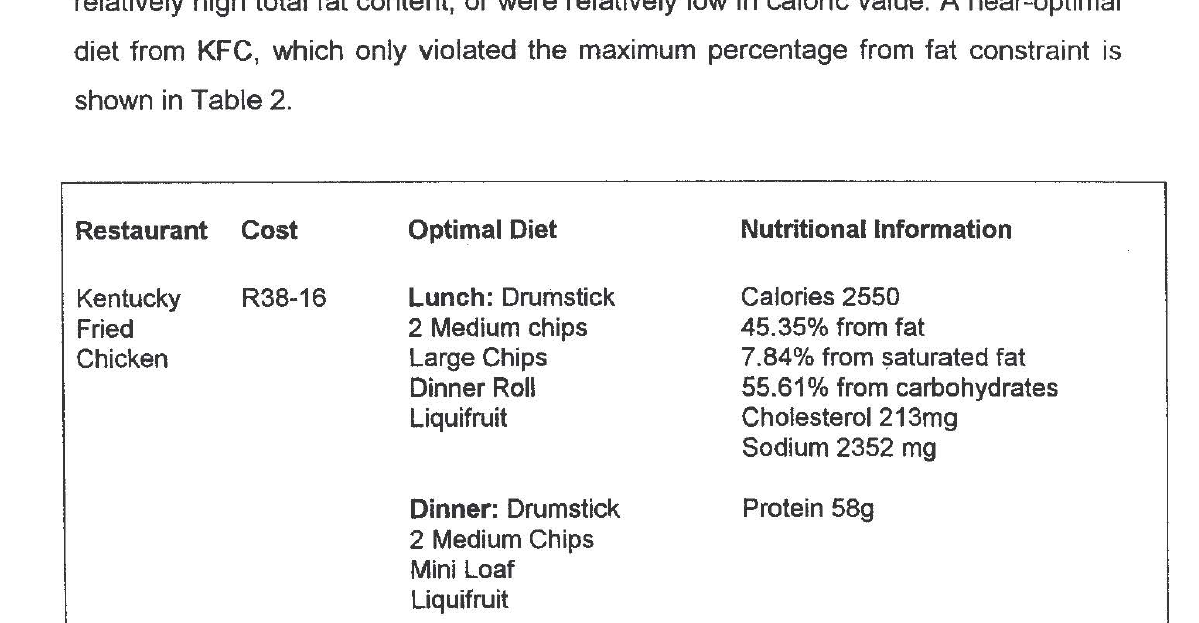
Table 2. Near-Optimal daily diet for Kentucky Fried